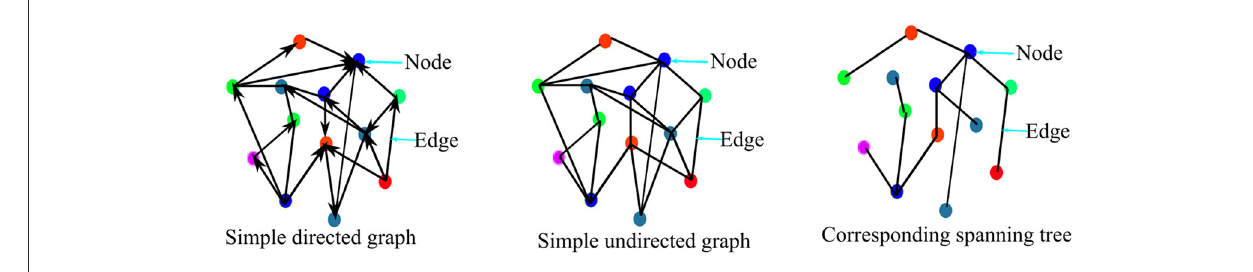
FIGURE3 Representation of the simple graph containing 13 nodes and 19